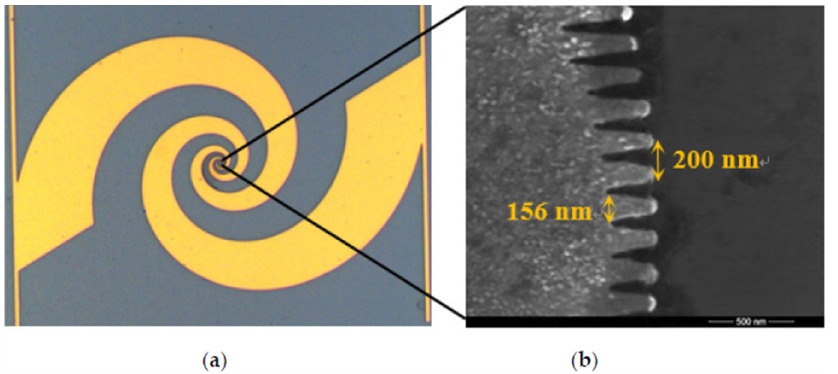
Figure 1. PCA with saw-toothed plasmonic contact electrodes and a conventional PCA. ( a ) Micro- scope image of the proposed PCA; ( b ) Scanning electron microscope of the designed saw-toothed plasmonic contact electrodes.